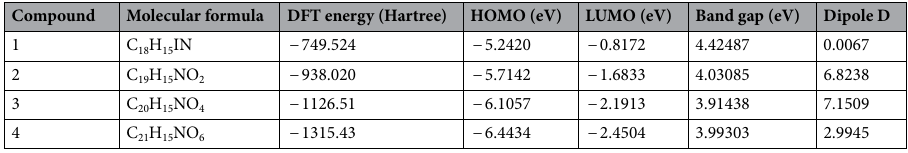
Table 2. Listing the HOMO–LUMO energy levels of Compounds 1 –